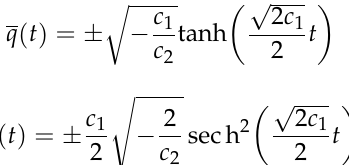
Figure 2. Stationary probability density of the system response. ( a )